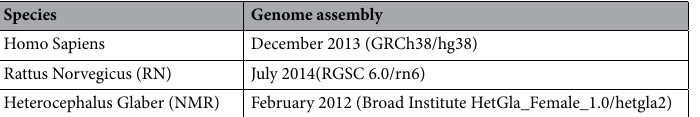
Table 1. Genome assemblies used for